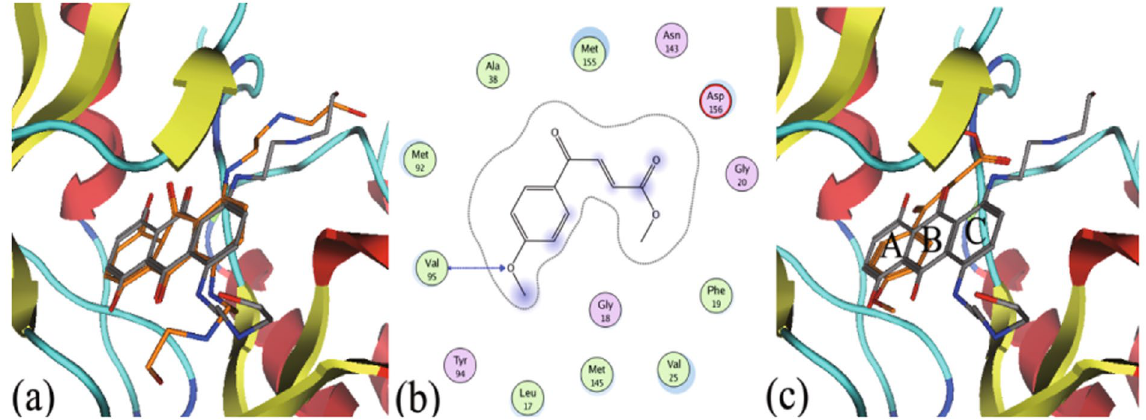
Figure 3. The predicted mode of IMB-YH-8 binding to PknB. ( a ) Superimposition of the predicted binding mode of mitoxantrone (in stick, carbon in orange) in the context of the crystal structure (in stick, carbon in grey). ( b ) The detailed interactions between IMB-YH-8 and PknB. ( c ) The alignment between the binding mode of IMB-YH-8 (in stick, carbon in orange) and MIX (in stick, carbon in grey). The receptor: hydrogen bond is indicated by the blue line with arrow.